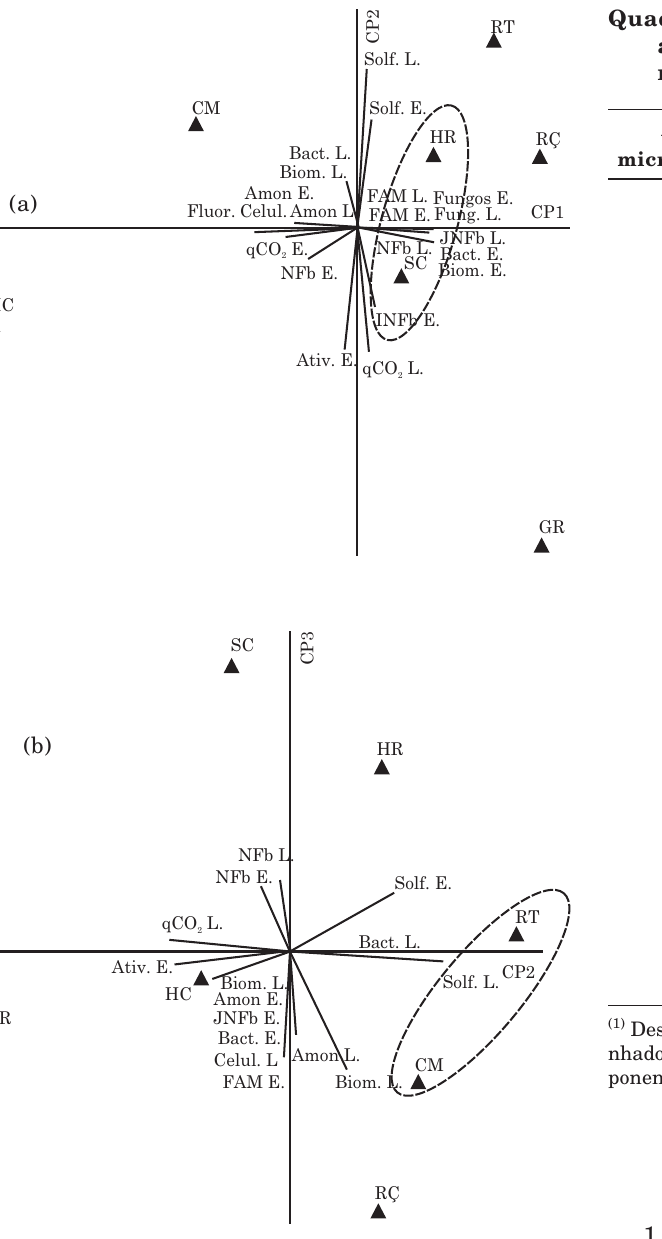
Figura 2. Análise de componentes principais